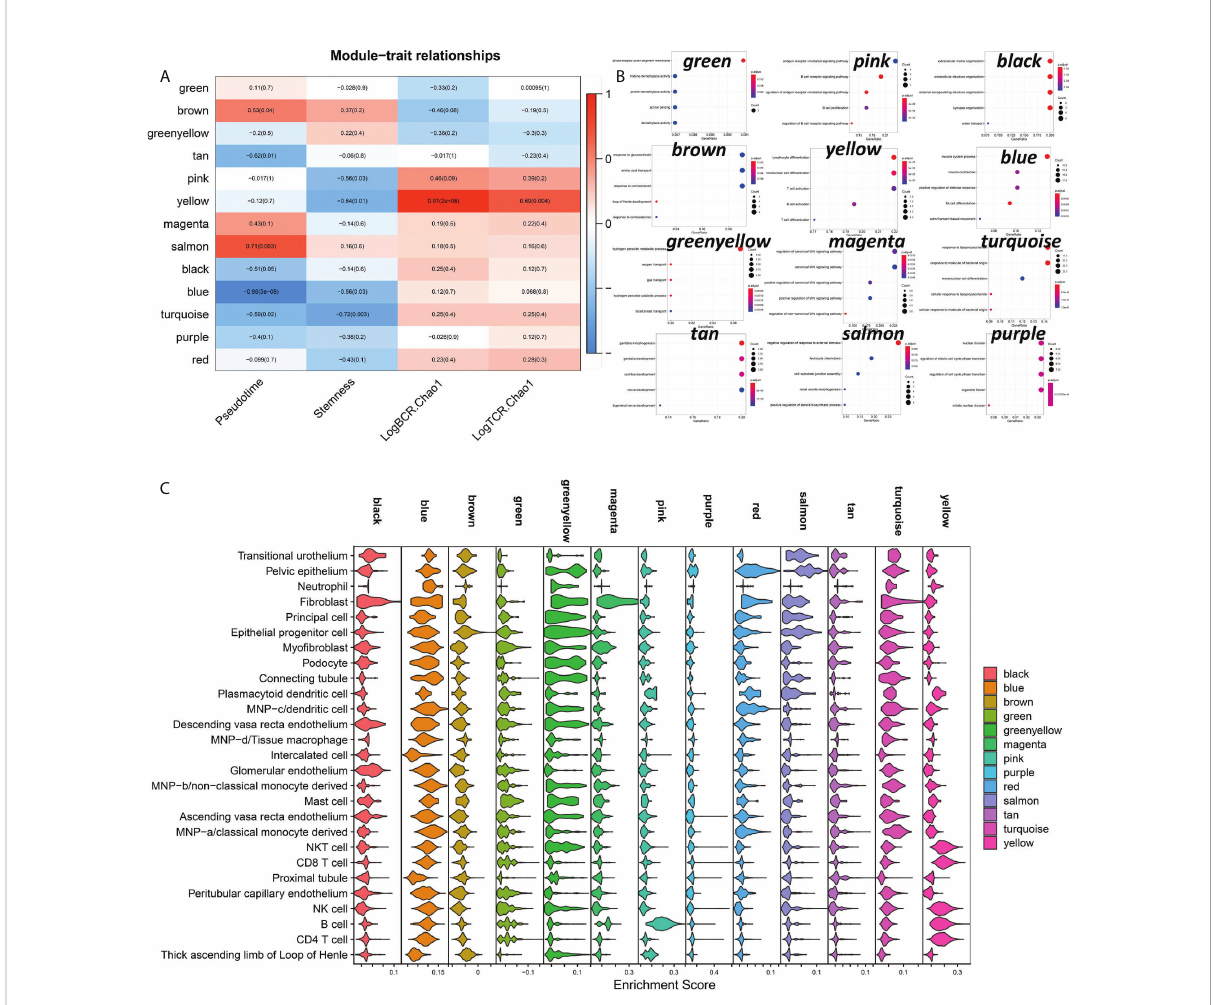
FIGURE 8 Analysis of co-expressed regulatory modules in the early stage of DN-ogenesis. (A) Correlation of 13 co-expression modules with Pseudotime, LogBCR_Chao1, LogTCR_Chao1 Stemness. (B) Functional enrichment analysis of the 12-module hub genes (KEGG gene sets). The hub genes of the Red module were not enriched for statistically signi fi cant signaling pathways. (C) Enrichment scores for 13 co-expression modules in 27 celltypes in kidney